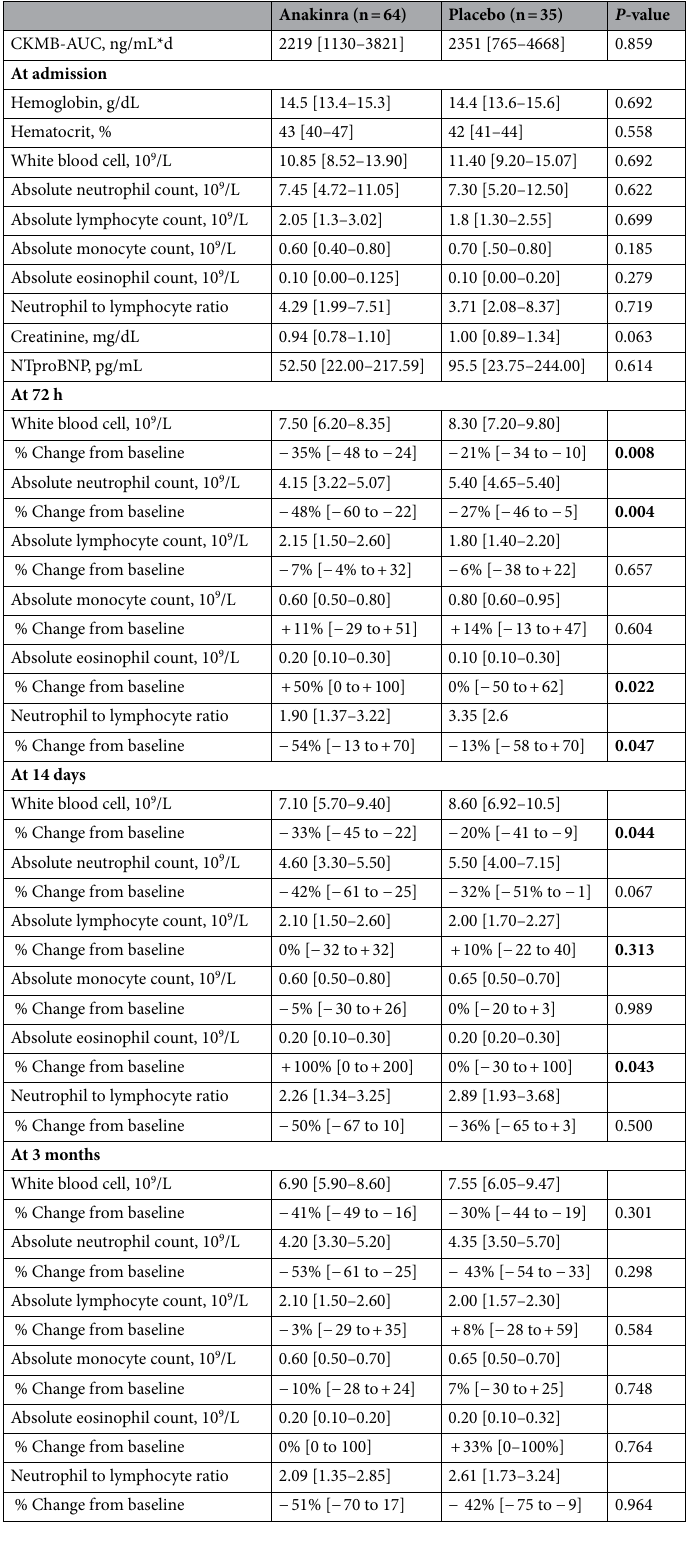
Table 2. Laboratory data according to anakinra and placebo. Data are expressed as median [interquartile range]. P -values in bold character indicate significant values (< 0.05) for difference between groups. CKMB- AUC Creatine kinase-MB area under the curve, CRP-AUC C-reactive protein area under the curve, NTproBNP N-terminal pro-brain natriuretic